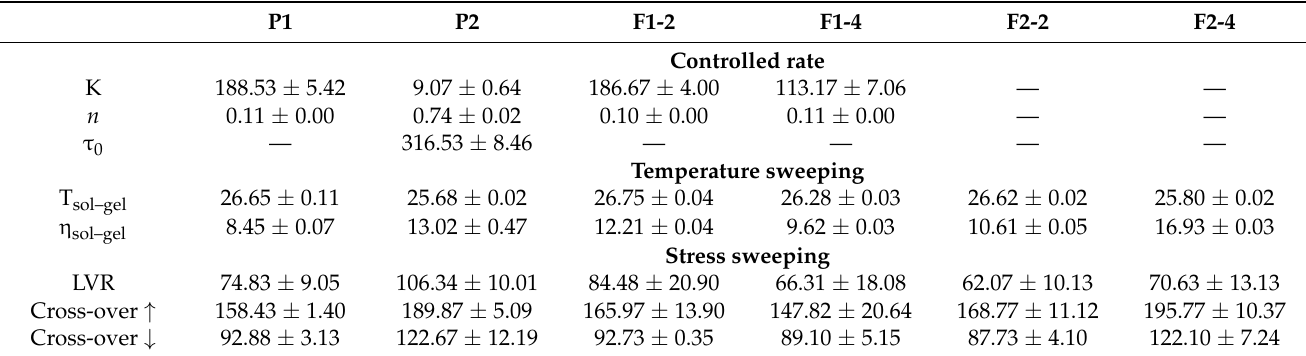
Table 3. Rheological parameters calculated for placebo and SBE/Cs 80:500 loaded hydrogels. P1